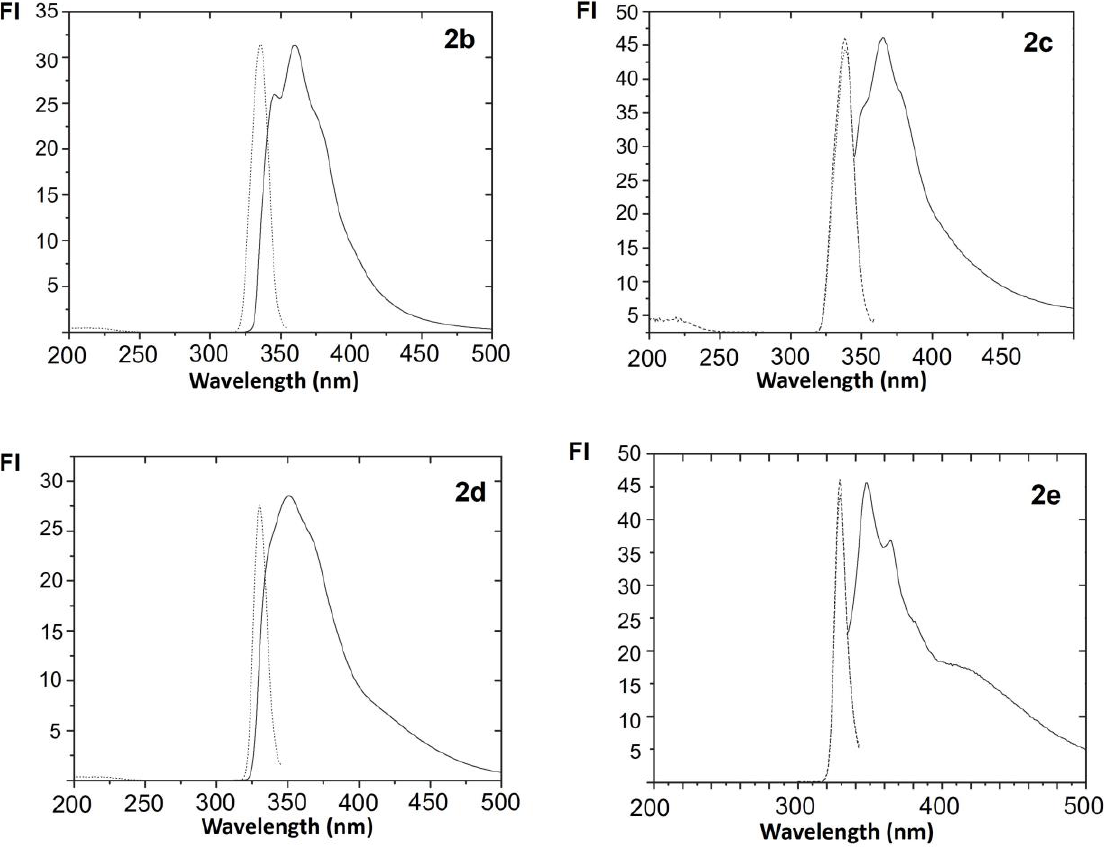
Figure 3. Corrected excitation and fluorescence emission spectra of 2b – 2e in acetone. The fluores- cence intensity (FI) in the excitation and emission spectra is normalised to the same intensity value. Wavelength in nm.